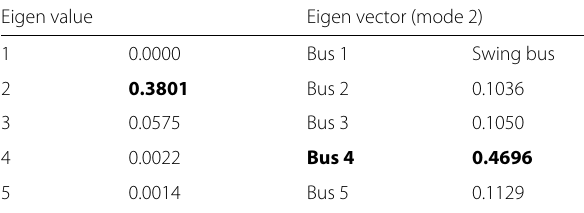
Table 2 Eigen values and Eigen vectors at Paruthippara SS Eigen value